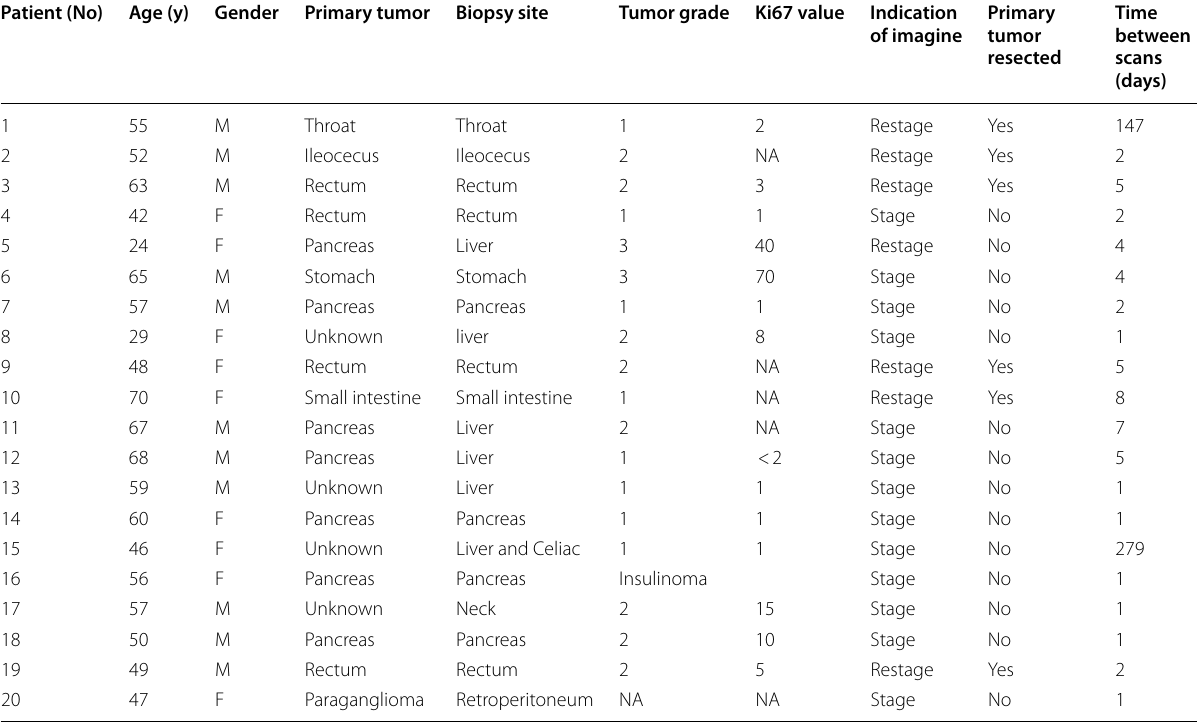
Table 1 Patient clinical